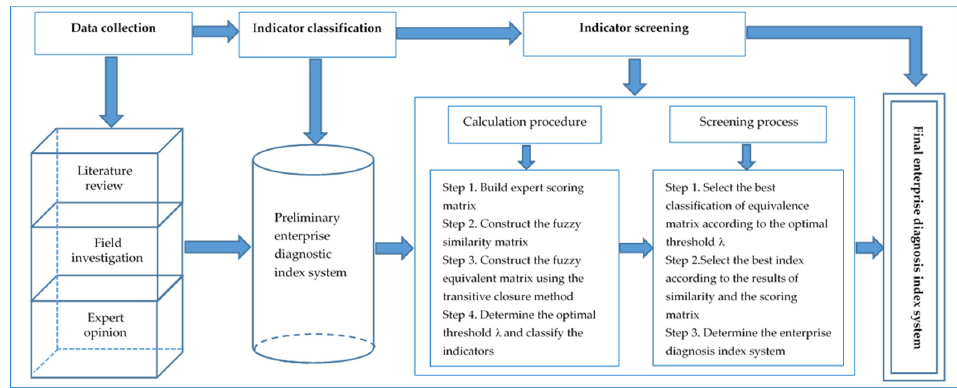
Figure 1. Flowchart of the proposed method. Step 1: Construct a scoring matrix